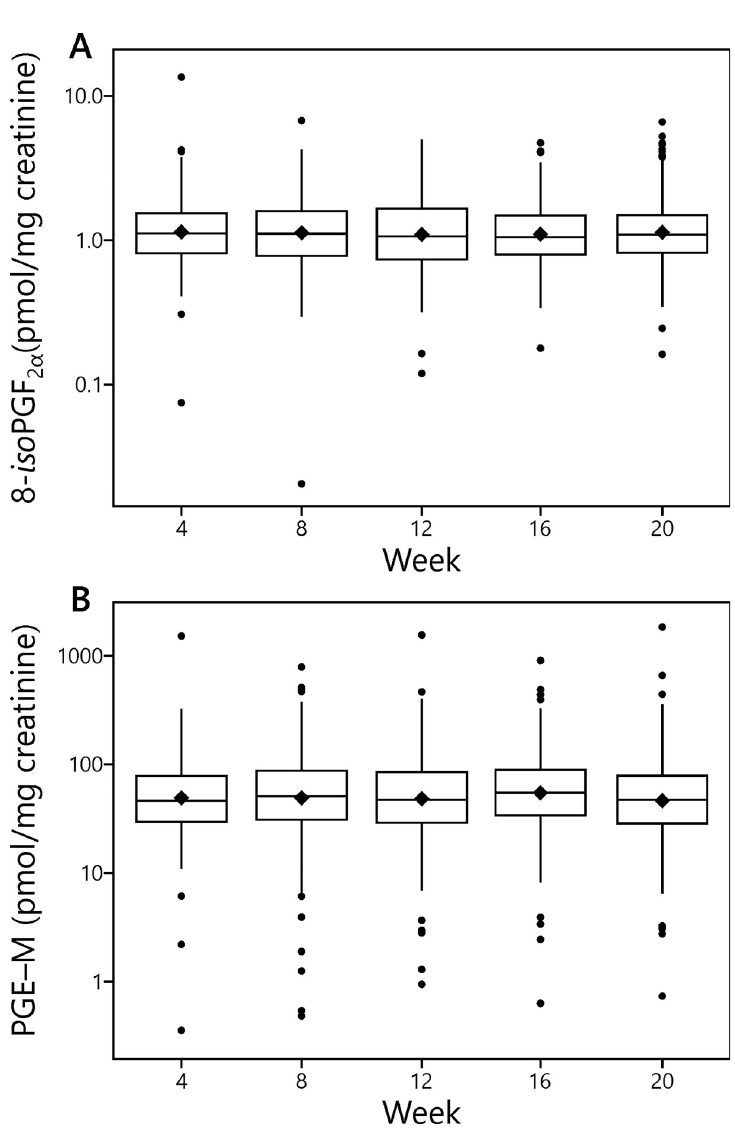
Fig 2. Mean creatinine-corrected values of 8- iso -PGF 2 α and PGE-M at each week of the study in the subjects who smoked the Spectrum cigarettes. Horizontal line inside the box, median; black diamond, mean; bottom and top edge of the box, 1 st and 3 rd quartile (interquartile range [IQR]); the upper whisker extends from the top of the box to the largest value no further than 1.5 times IQR and the bottom whisker extends from the bottom of the box to the smallest value no further than 1.5 times IQR; the y-axis is in the natural log